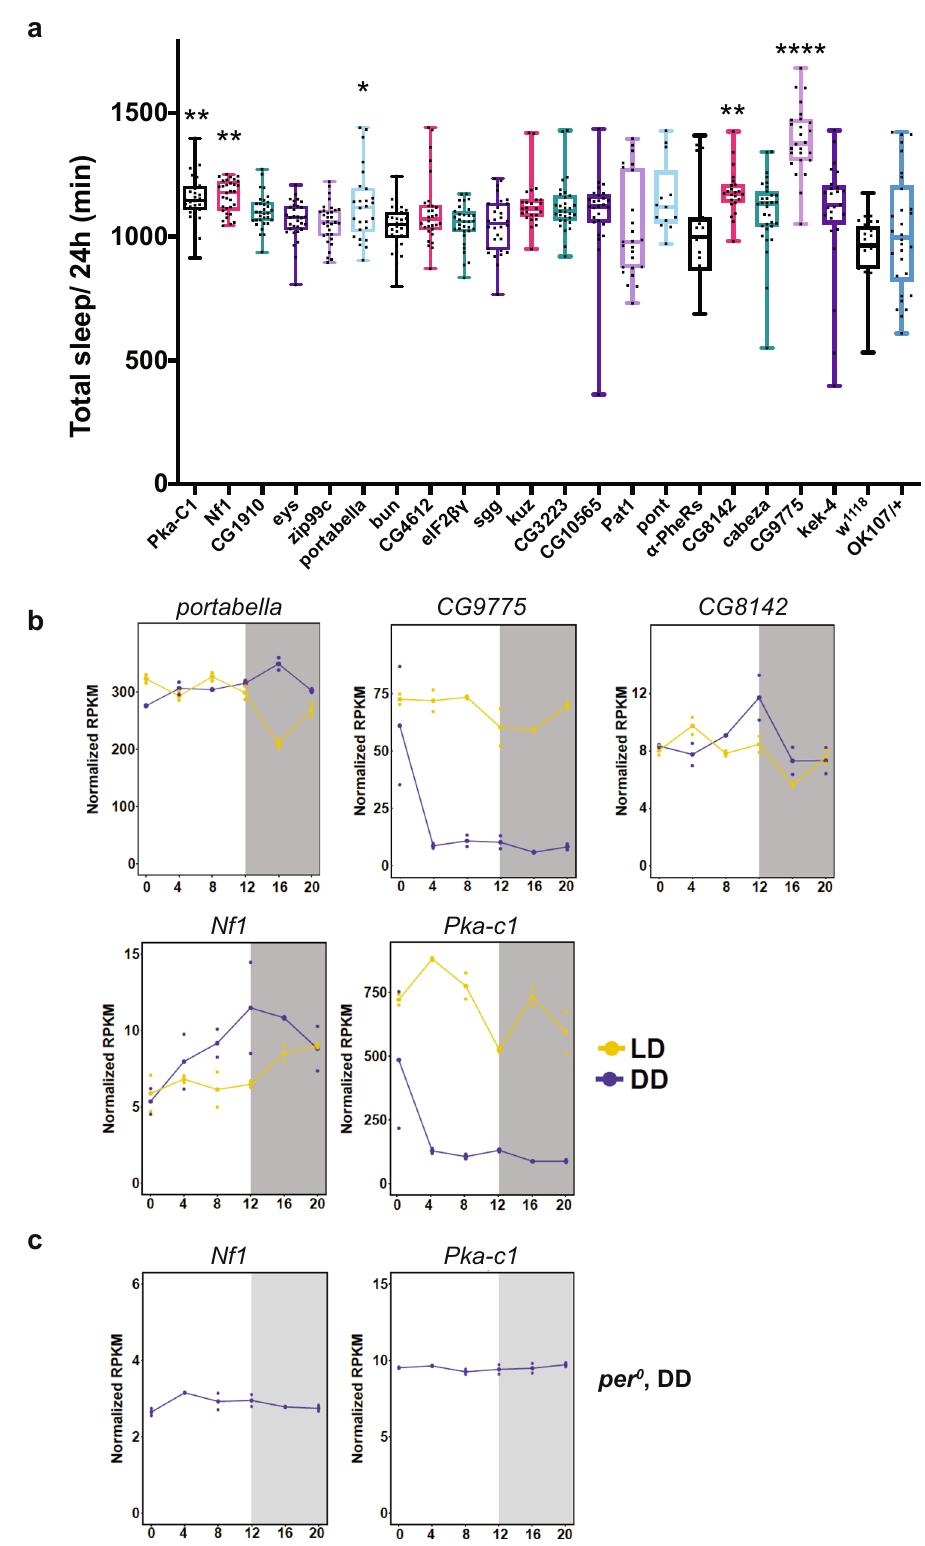
consistent with those of previous studies and further de fi ne the